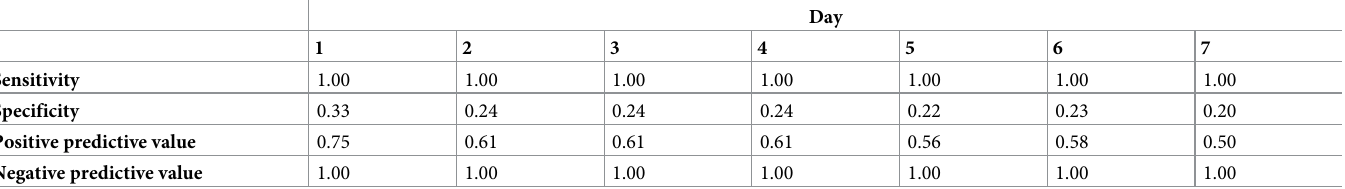
Table 3. Classification table output to assess the effectiveness of the survey collected data for predicting contacts. The networks formed with the tag-collected data represents the gold standard and the network formed with information from the survey represents the test. The test sensitivity always correctly predicted the existence of contacts, however, the specificity was relatively low, indicating an inability to correctly predict an absence of contacts. Both the positive and negative predictive values were relatively high ( �